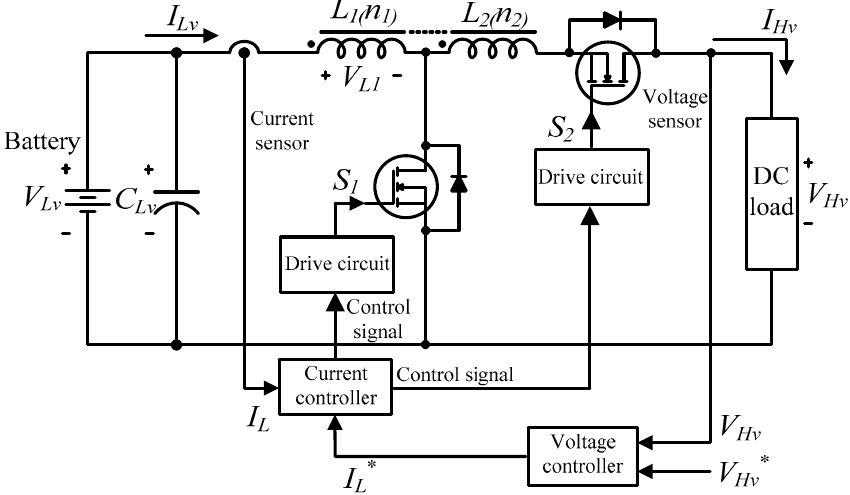
/ buck-ratio bidirectional